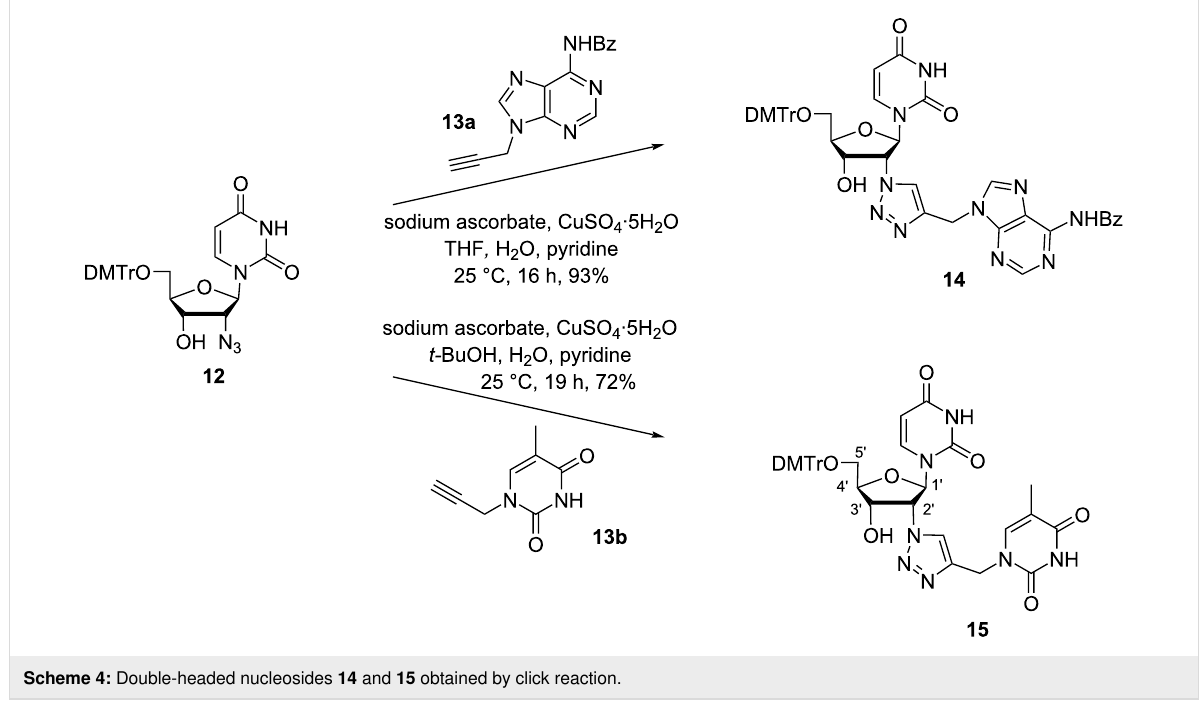
Scheme 4: Double-headed nucleosides 14 and 15 obtained by click reaction.